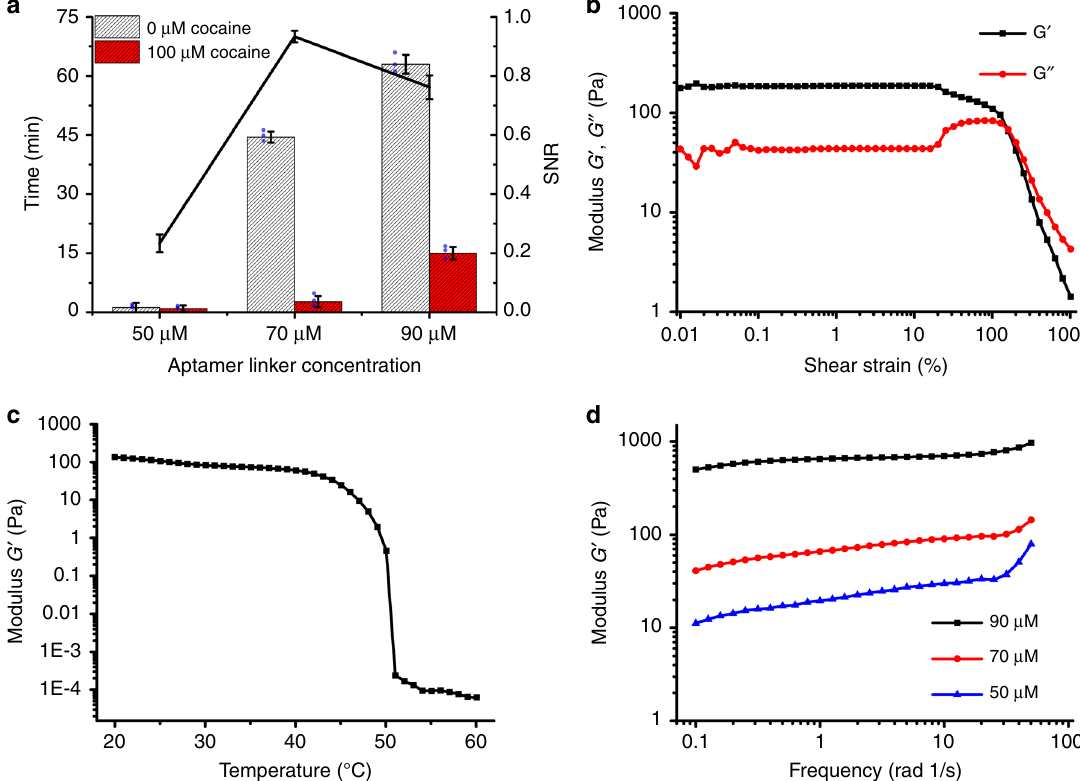
Fig. 4 Optimization and characterization of DNA hydrogels. a The fl ow-through time (left y -axis) and SNRs (right y -axis) obtained from different linker concentration of hydrogels for the detection of 0 and 100 µ M cocaine using the CSDR-Sensor. Each data point is an average of three replicates ( N = 3), and the error bars indicate the standard deviations. b The storage modulus G ′ and loss modulus G ″ of the DNA hydrogel (70 µ M aptamer linker) changes with shear strain. c Variation of the storage modulus G ′ value of the hydrogel function of temperature at a linker DNA concentration of 70 µ M. d Storage modulus G ′ at 25 °C as a function of shear frequency for DNA hydrogels prepared with different aptamer linker